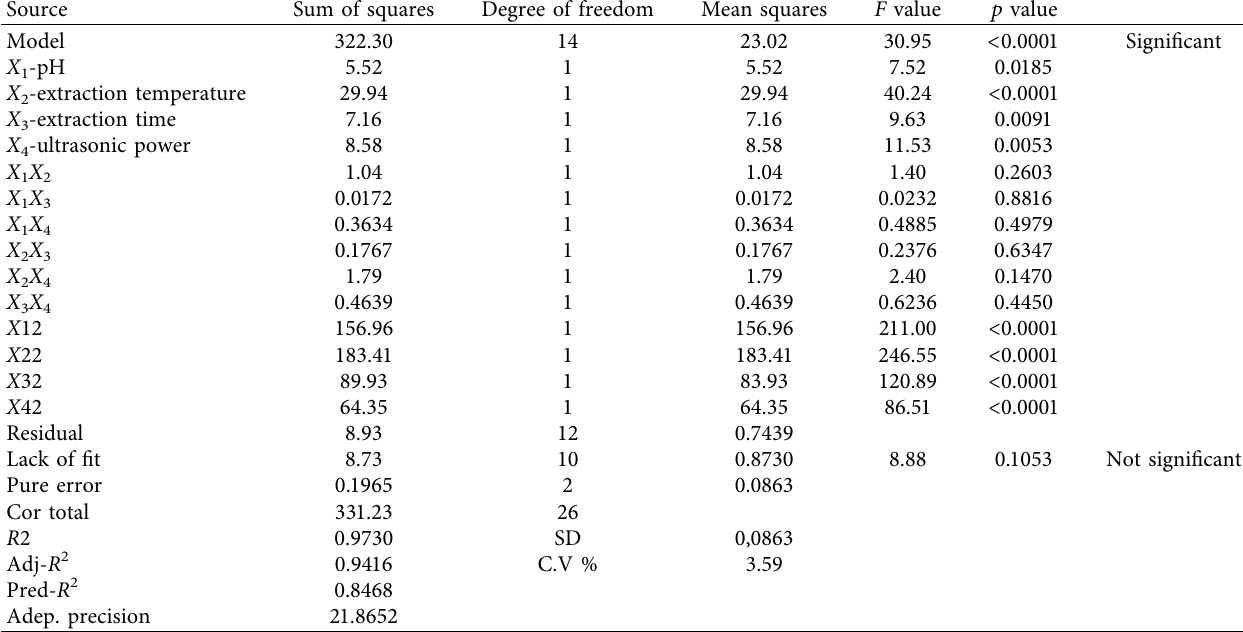
Table 3: ANOVA for the second-order polynomial model.